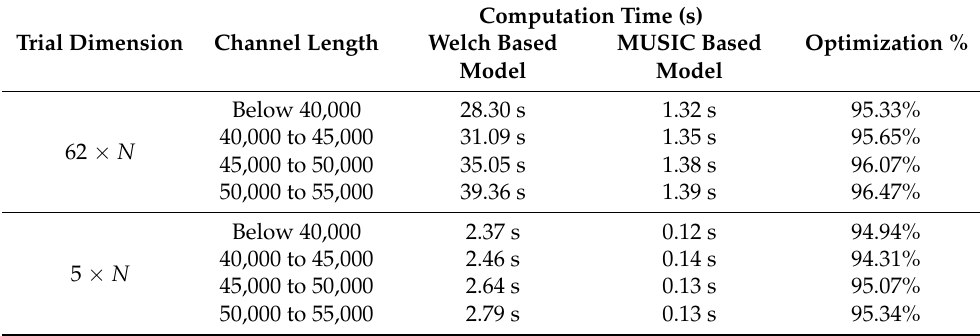
Table 3. Investigated computation-time metadata for non-parametric feature-extraction method (Welch model) vs MUSIC